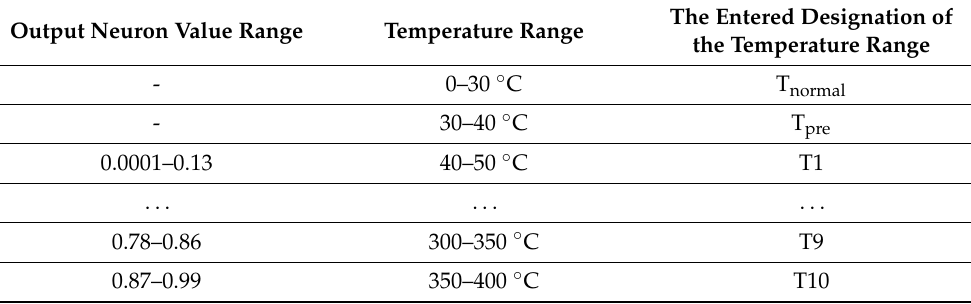
Table 1. Output neurons with the temperature of the steel